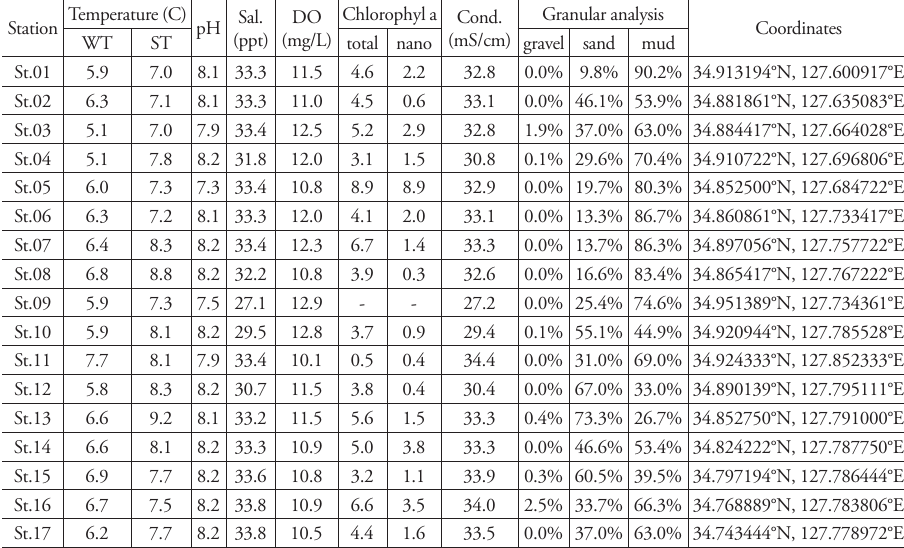
Table 1. Environmental conditions at 17 sampling stations in Gwangyang Bay, rescorded on 18 January 2006. Water temperature was measured on the surface. Granular analysis was conducted manually ac- cording to the protocol described by Folk (1974). Abbreviations: WT, water temperature; ST, sediment temperature; Sal., salinity; DO, dissolved oxygen; Cond., conductivity.